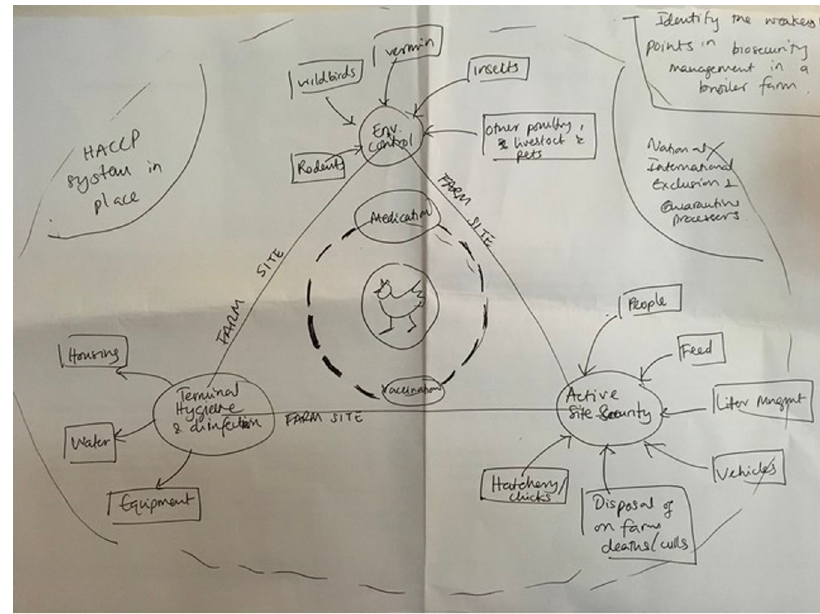
Fig. 1 An initial sketch of the the visualisation tool. Initial sketch of the disease control/biosecurity participatory tool prepared by service designers.